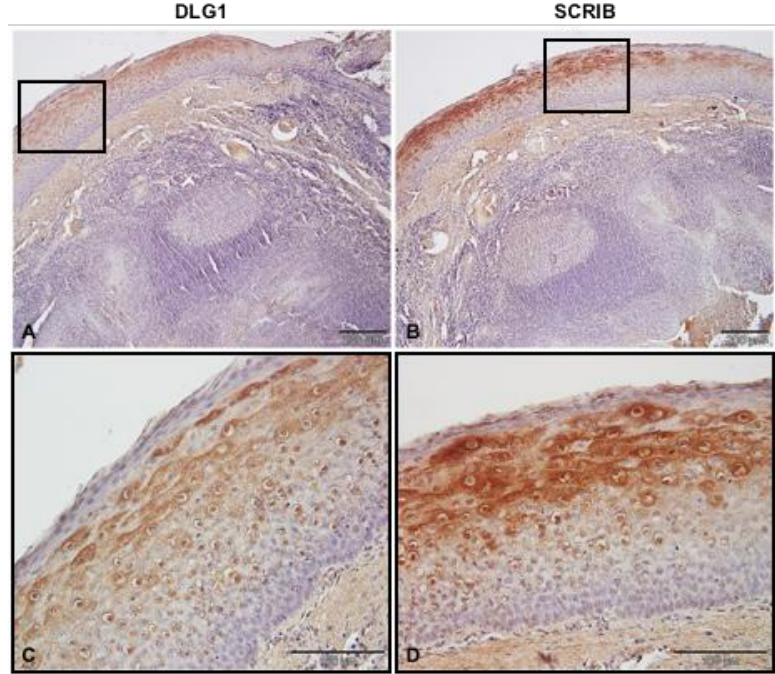
Figure 2. DLG1 and SCRIB expression in cancer-free normal tonsillar tissues. Paraffin-embedded biopsies were immunostained with anti-DLG1 and anti-SCRIB antibodies, counter stained with hematoxylin, and visualized by a light microscope. Representative images: ( A ) Positive cytoplasmic and membranous DLG1 immunoreactivity in squamous cell epithelium. ( B ) Positive cytoplasmic and membranous SCRIB immunoreactivity in squamous cell epithelium. ( C , D ) Enlargements of ( A ) and ( B ), respectively. Scale bars = 200 μ m ( A , B ); 100 μ m ( C , D ).